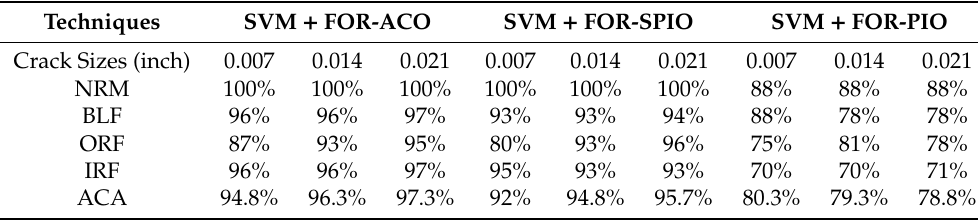
Table 5. The Accuracy of Single-Type Fault Identification When the Torque Load is 0-hp.